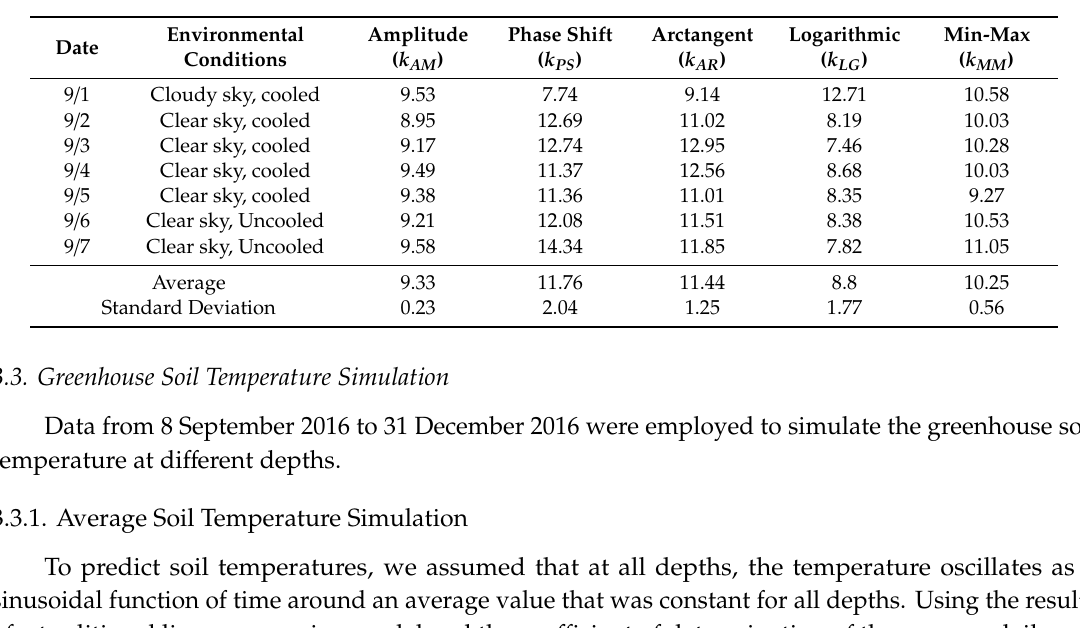
Table 1. Comparison of the apparent soil thermal diffusivity k (×10 − 7 m 2 s −1 ) determined from amplitude, phase-shift, arctangent, logarithmic, and min-max methods using field data collected